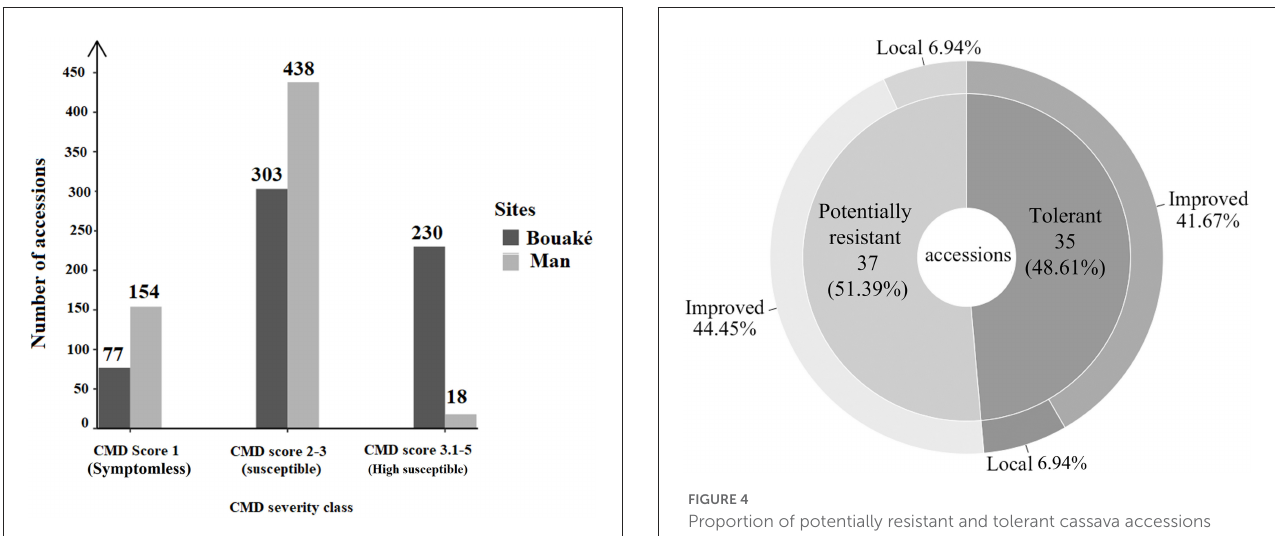
FIGURE2 Proportion of symptomless, susceptible, and highly susceptible cassava accessions observed in 610 Côte d’Ivoire cassava germplasm collection maintained at Bouaké and Man sites.